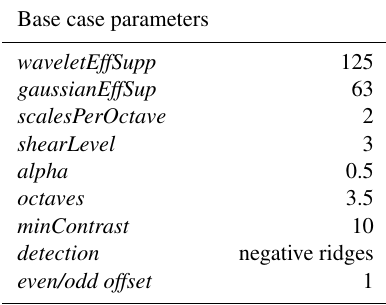
Table 3. Shearlet system and detection parameters used to extract ridges for the base